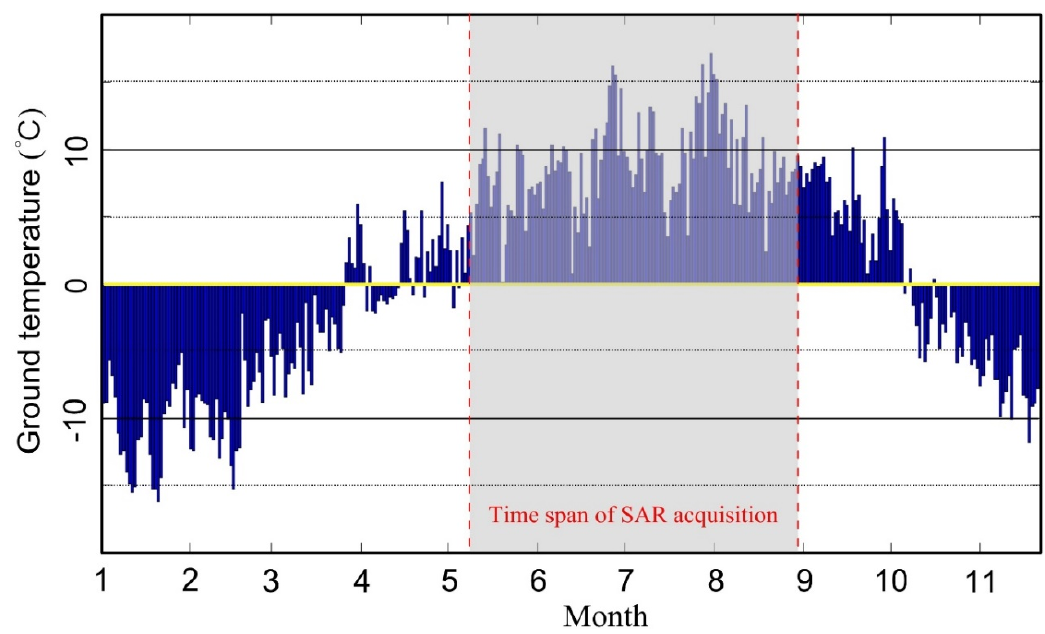
Figure 4. the daily average ground temperature in 2015 at the Qinghai weather station. Figure 4. The daily average ground temperature in 2015 at the Qinghai weather